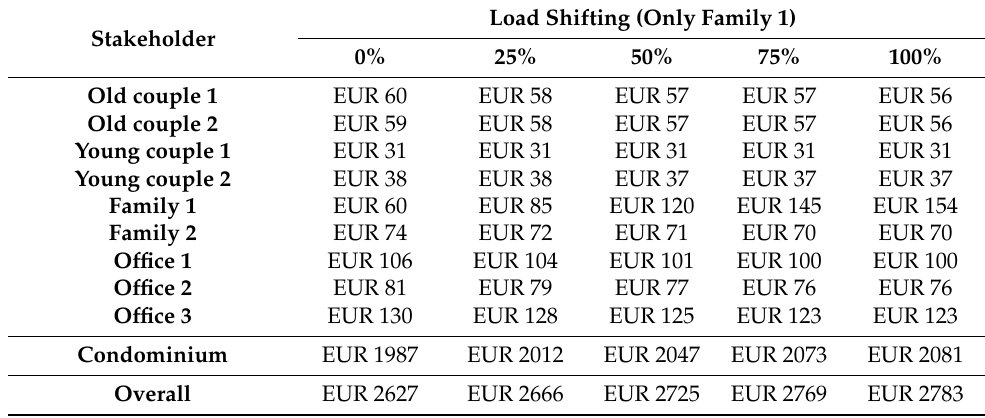
Table 9. Yearly revenue of each stakeholder of the configuration for Scenario A-EC, considering different levels of load shifting from user Family